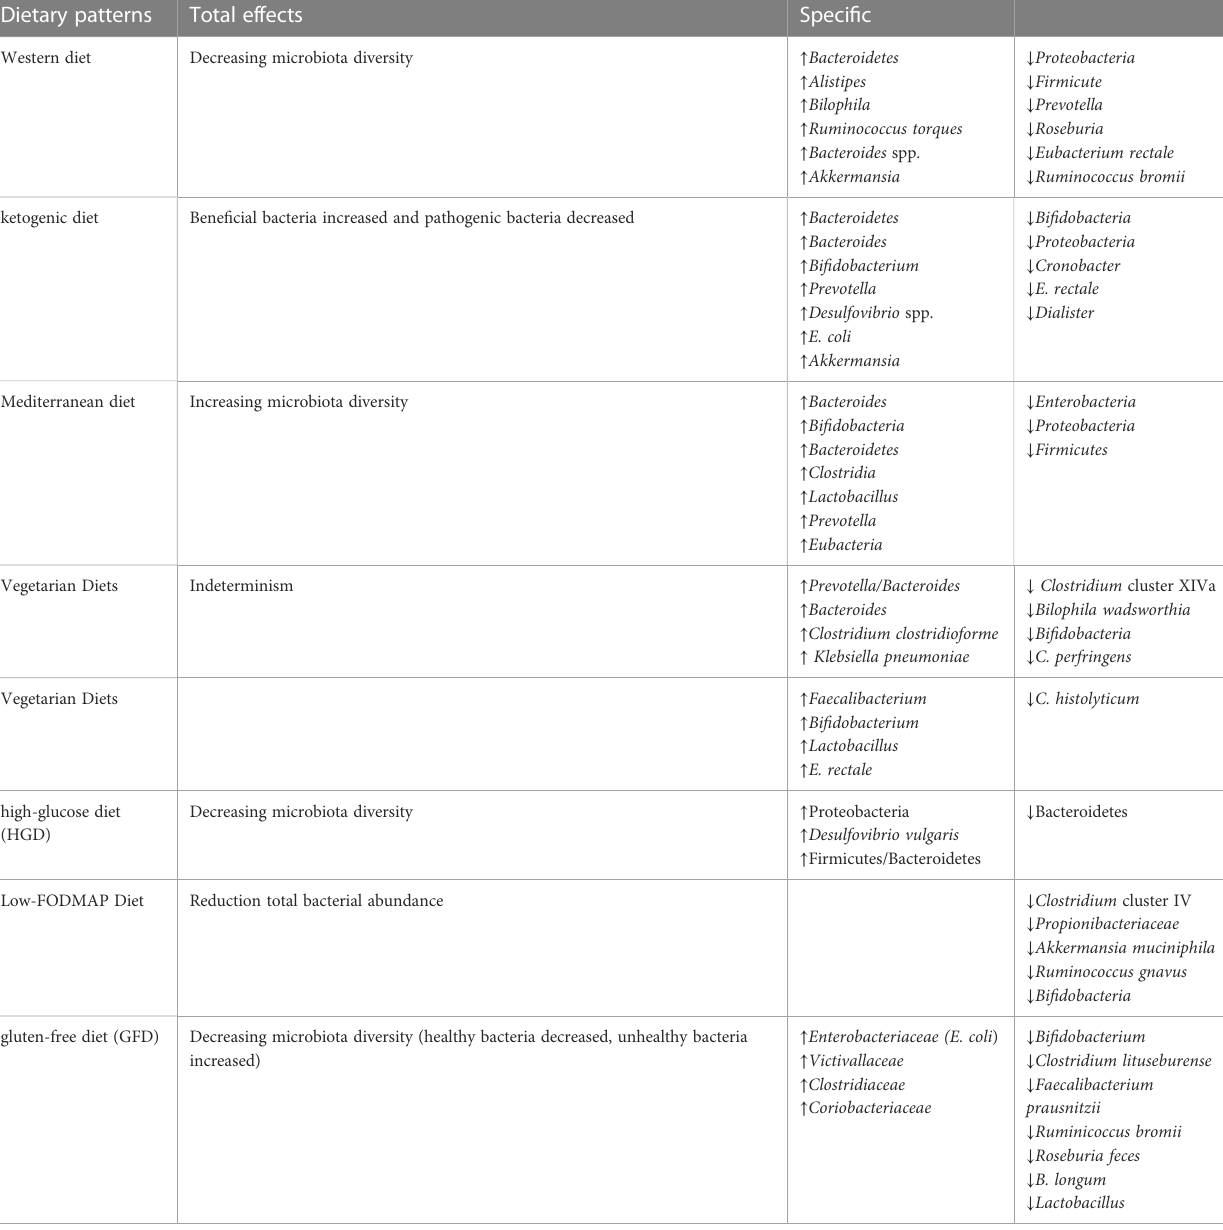
TABLE 1 Effects of different dietary patterns on the gut